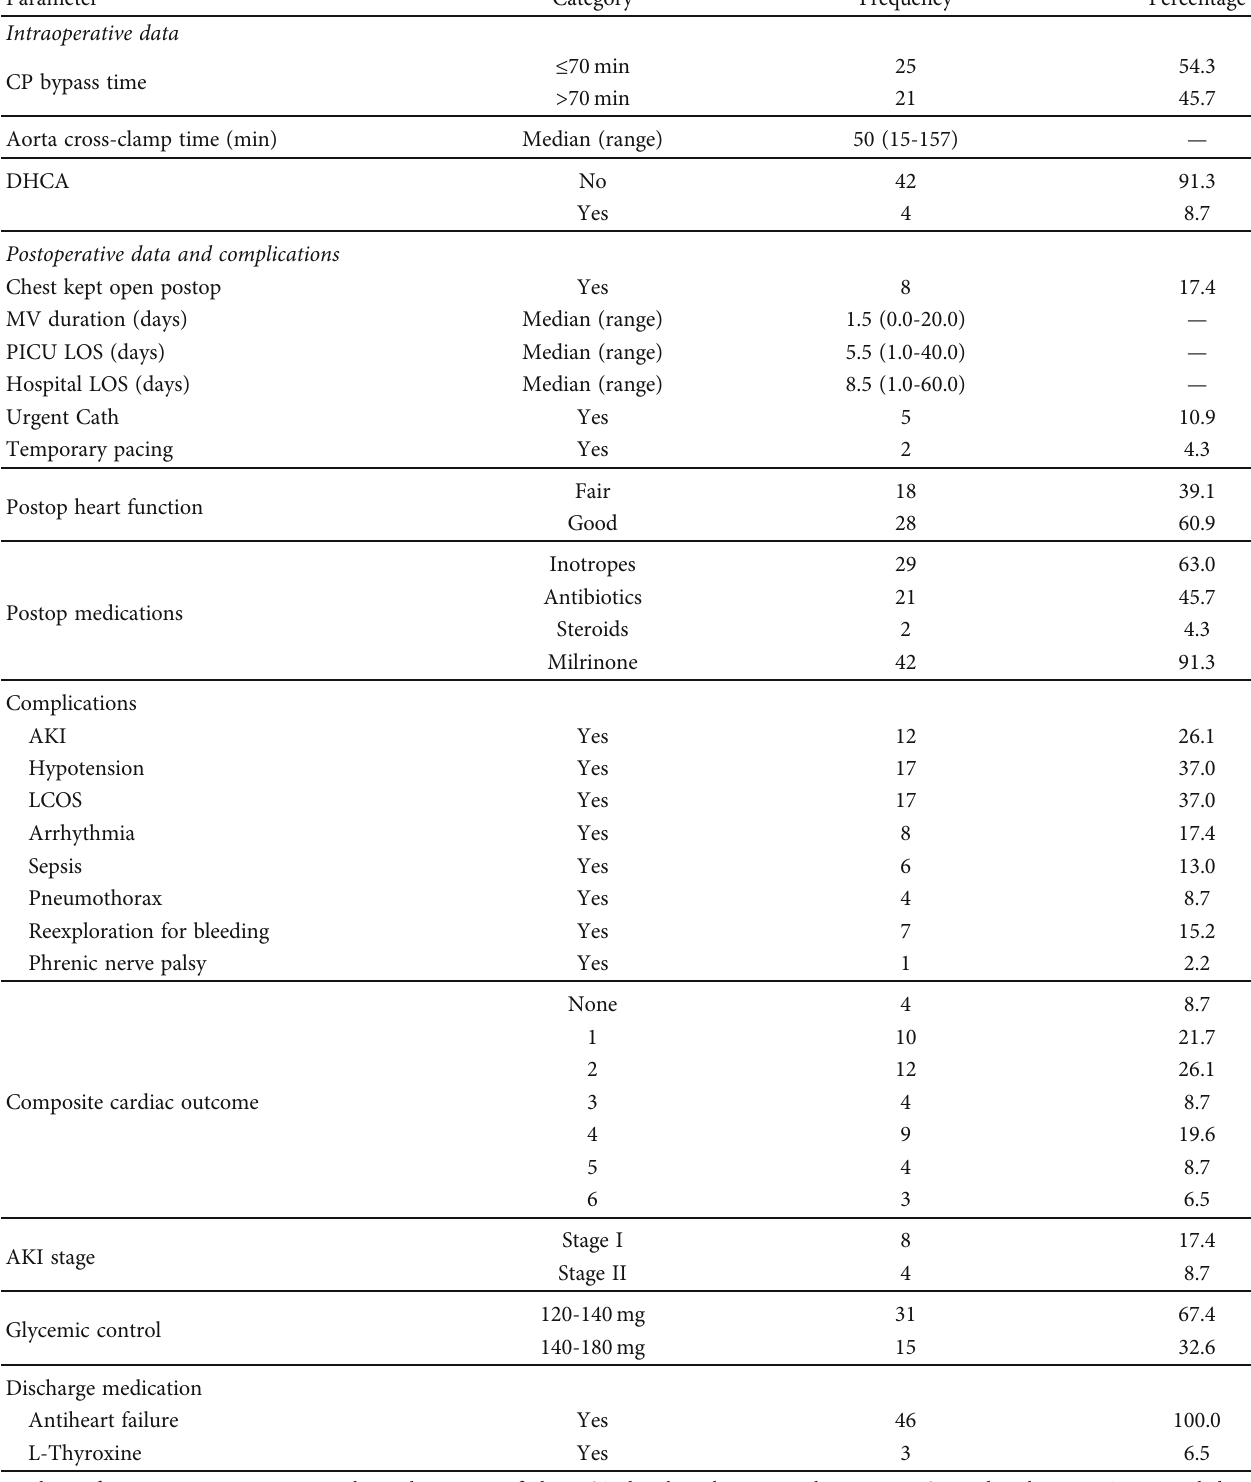
Table 2: Intraoperative and postoperative characteristics ( N = 46